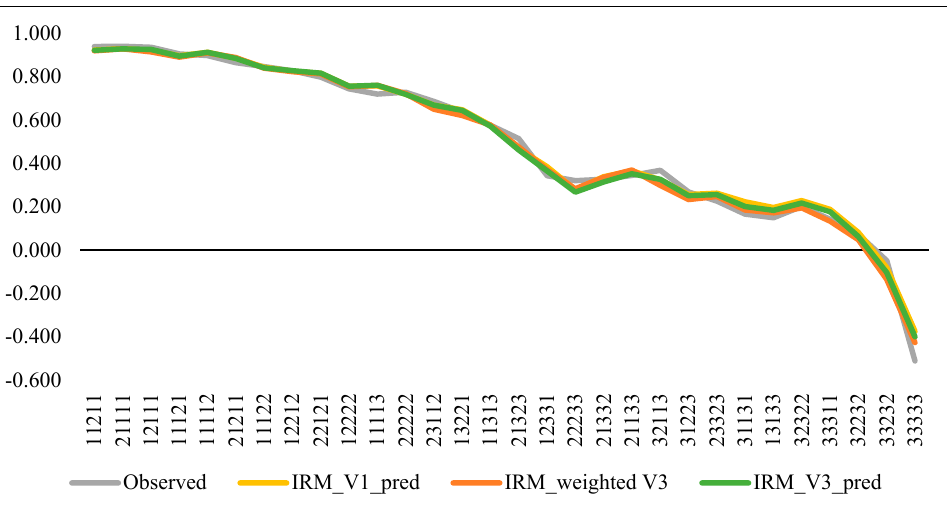
* p -value < 0.05; shaded columns—final model chosen. Finally, we tested the prediction accuracy of the RO model in dataset V1 and the weighted V3 dataset by comparing the predicted values with the observed mean TTO values for each evaluated health state. As shown in Figure 1, the model estimated well the mean observed values in all cases.